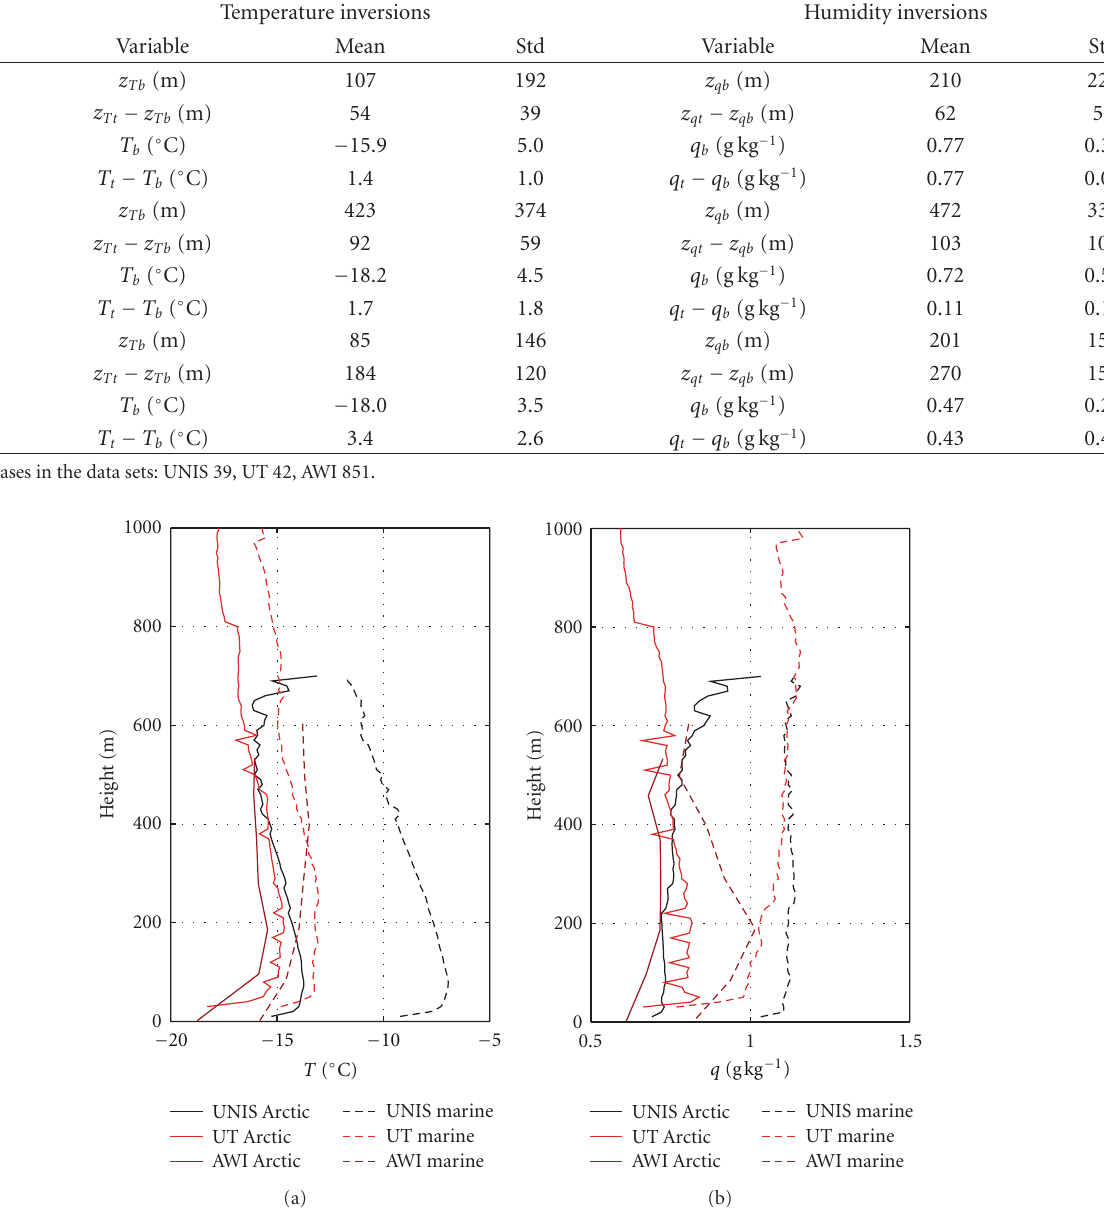
Figure 5: Mean profiles of the air temperature and specific humidity according to the UNIS, UT, and AWI soundings in cases of air masses of marine and Arctic